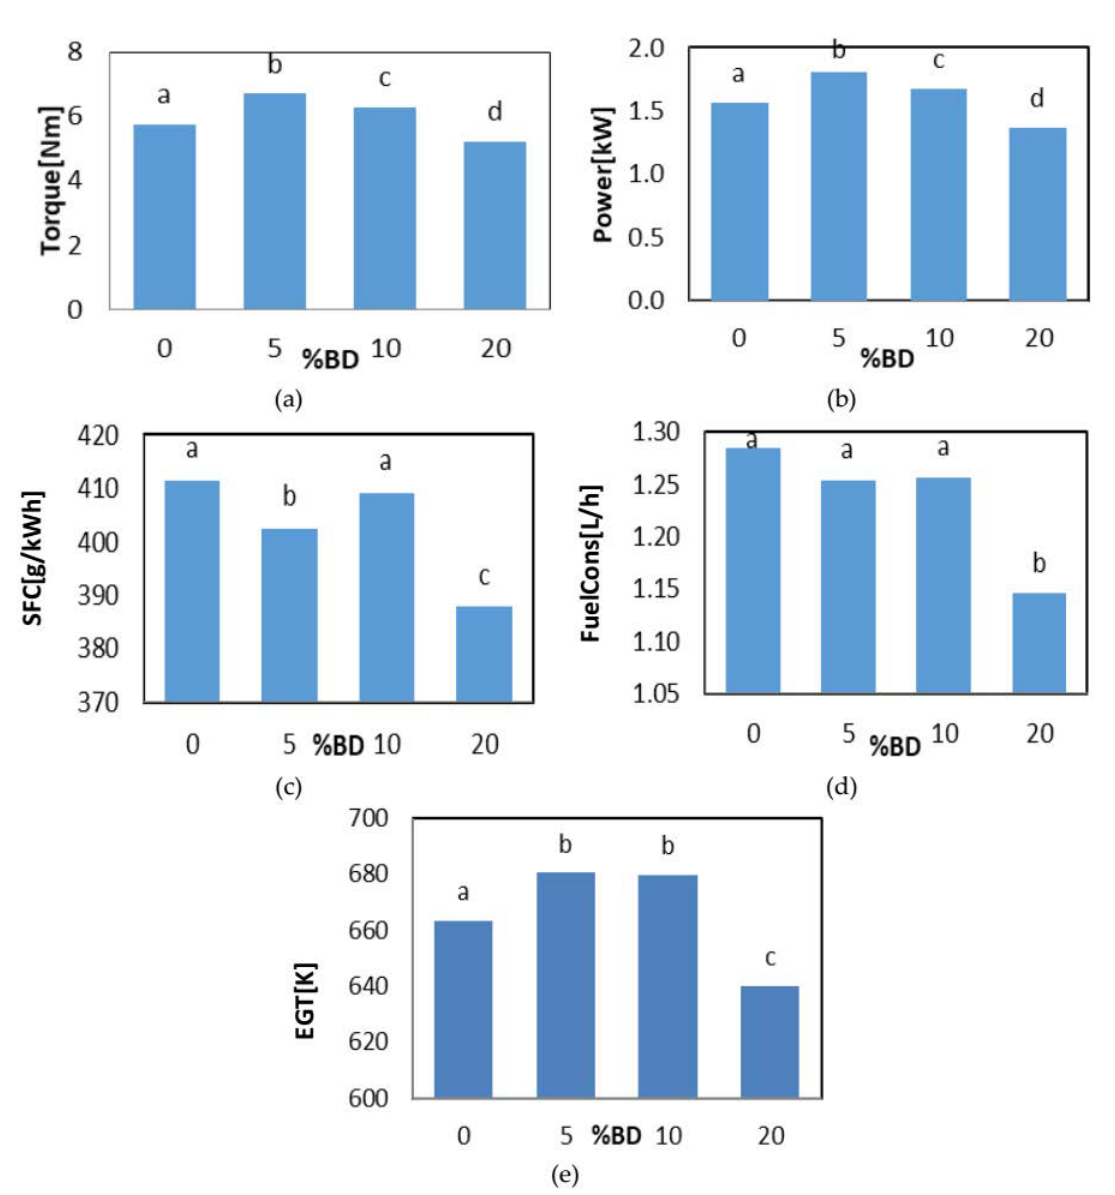
Figure 2. Means Di ff erence of ( a ) Torque; ( b ) Power; ( c ) Specific Fuel Consumption (SFC); ( d ) Fuel Consumption (FC); ( e ) Exhaust Gas Temperature (EGT) for groups in homogeneous subsets chart. Di ff erent letters ( a – d ): Significant di ff erence at the level of